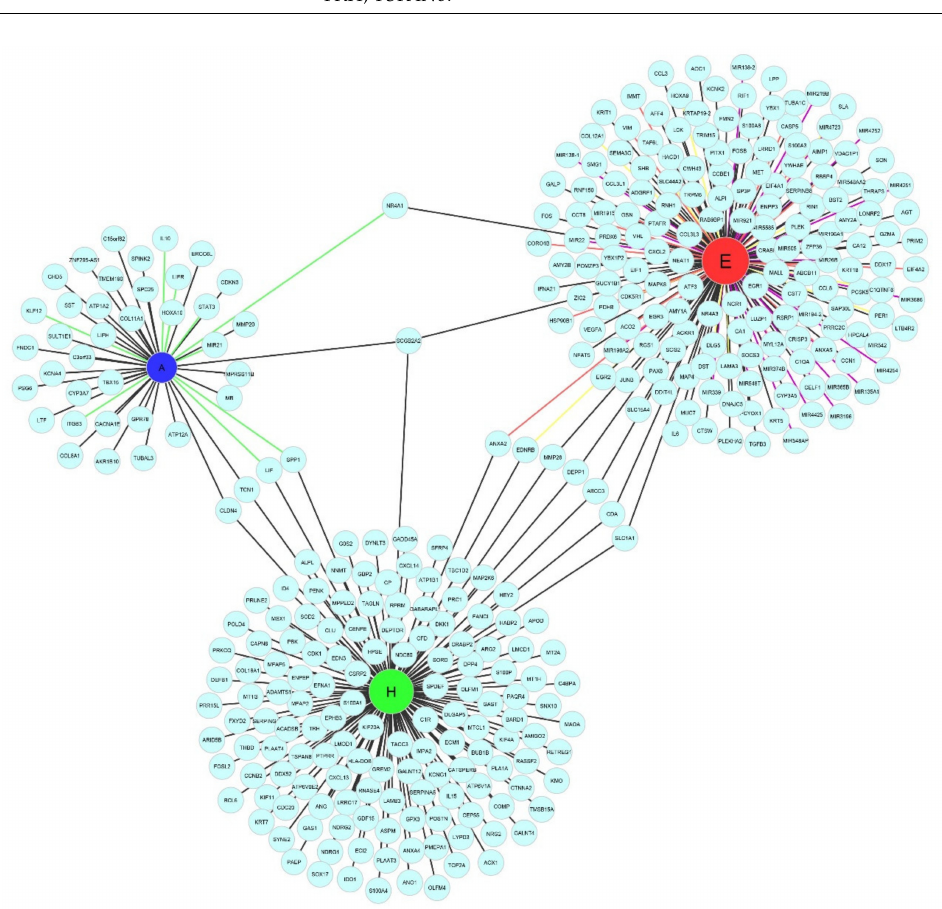
Figure 2. Retrieved genes associated with endometrial receptivity in women with adenomyosis (A = 42) or endometriosis (E = 173) and healthy women (H = 151) and overlap across groups. Colour of edges between genes represents the type of study design / omics level from which genes with reported molecular dysregulation were retrieved through literature mining: green, candidate protein / gene study design; black, transcriptomics study design; yellow, proteomics study design; red, epigenomics study design; and violet, ncRNomics study